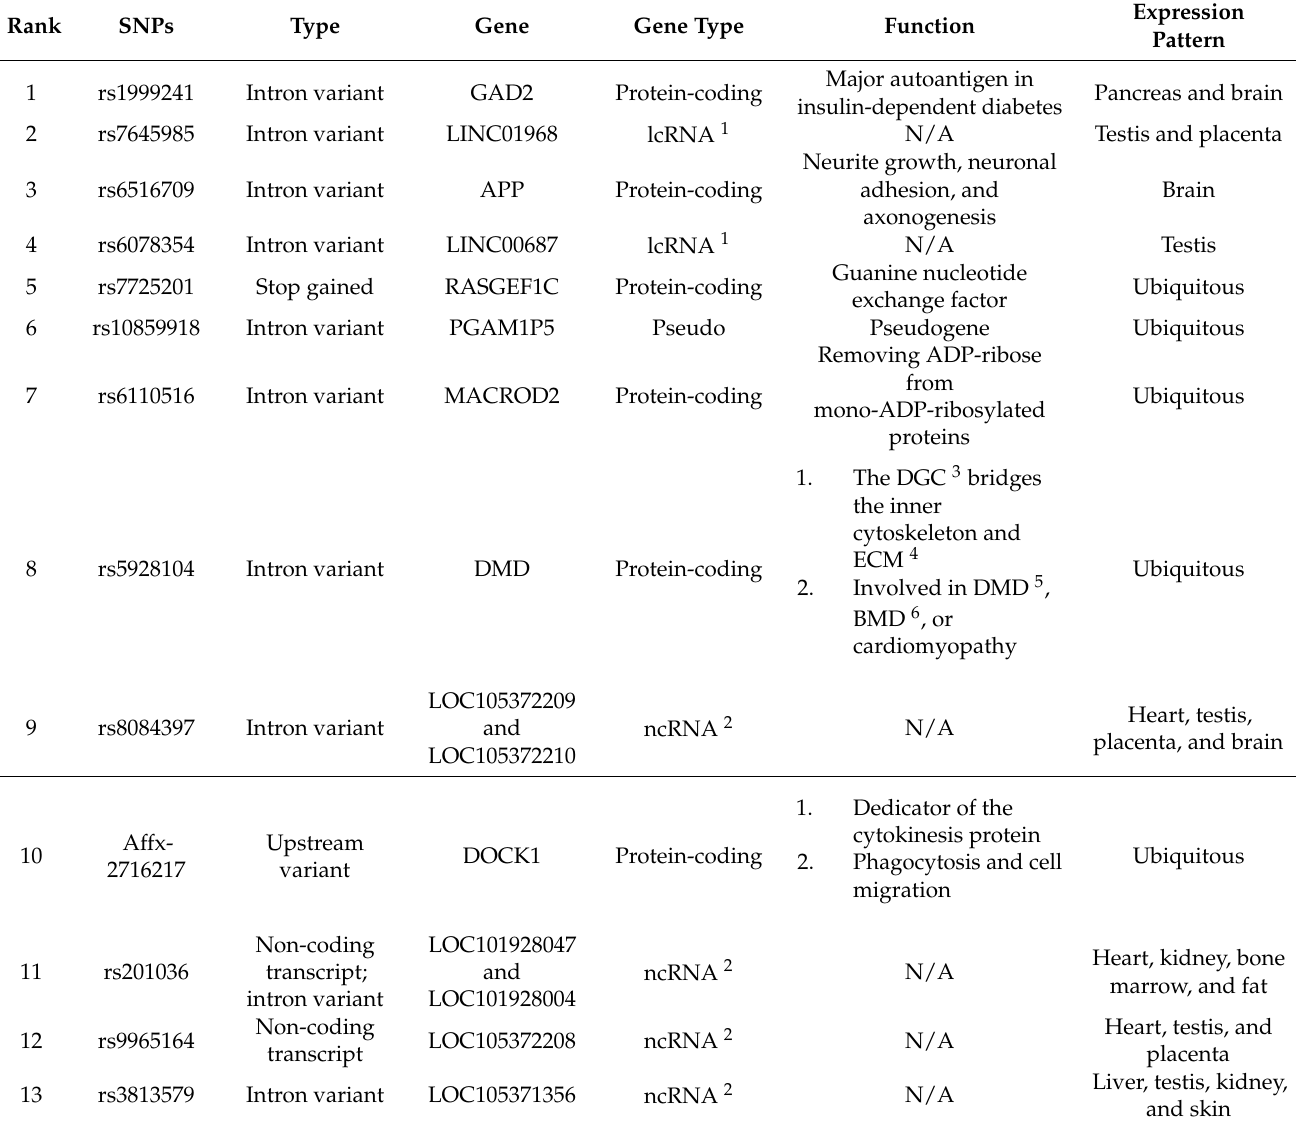
Table 5. Stage A vs. Stage B: feature